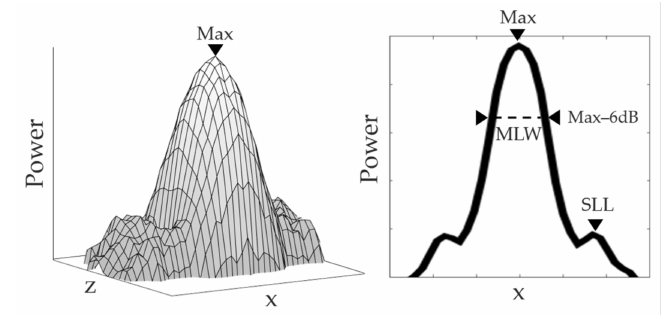
Figure 2. PSF example. The power represents the image intensity at a given point. PSF ( x ) is defined at z , where the power is maximum. Main lobe width and side lobe levels are found as illustrated.